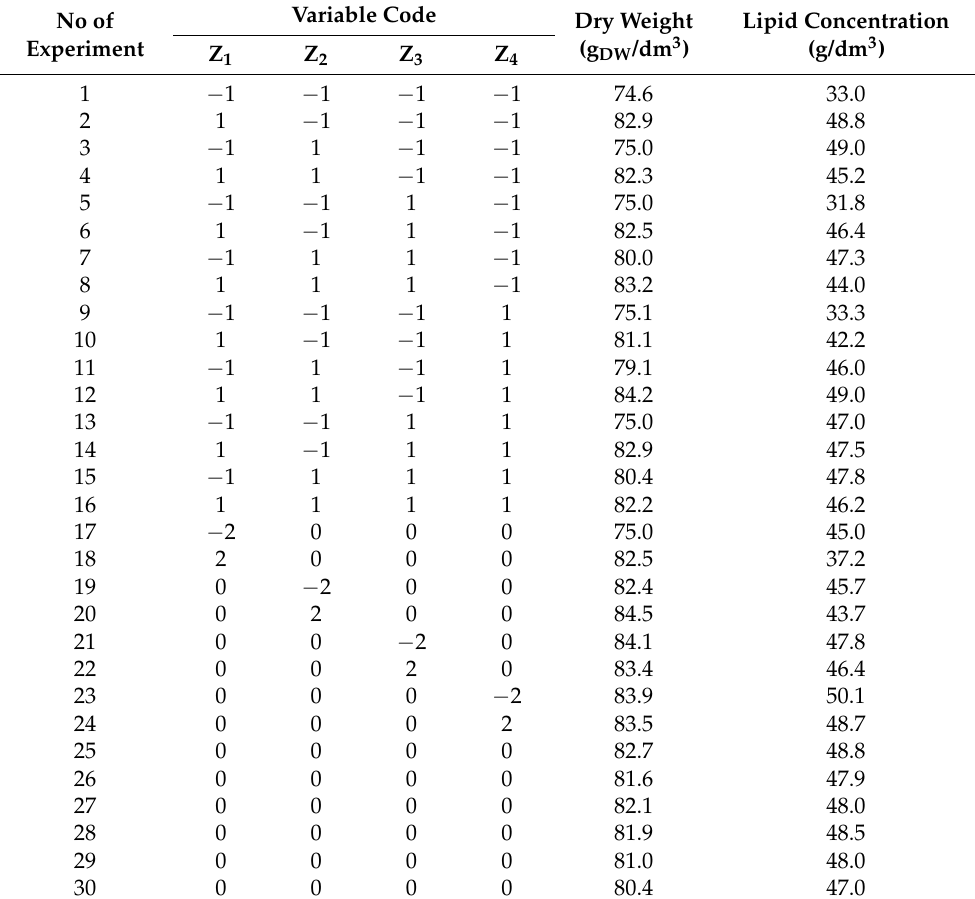
Table 9. CCD-optimized variables at different levels, with experimental results.